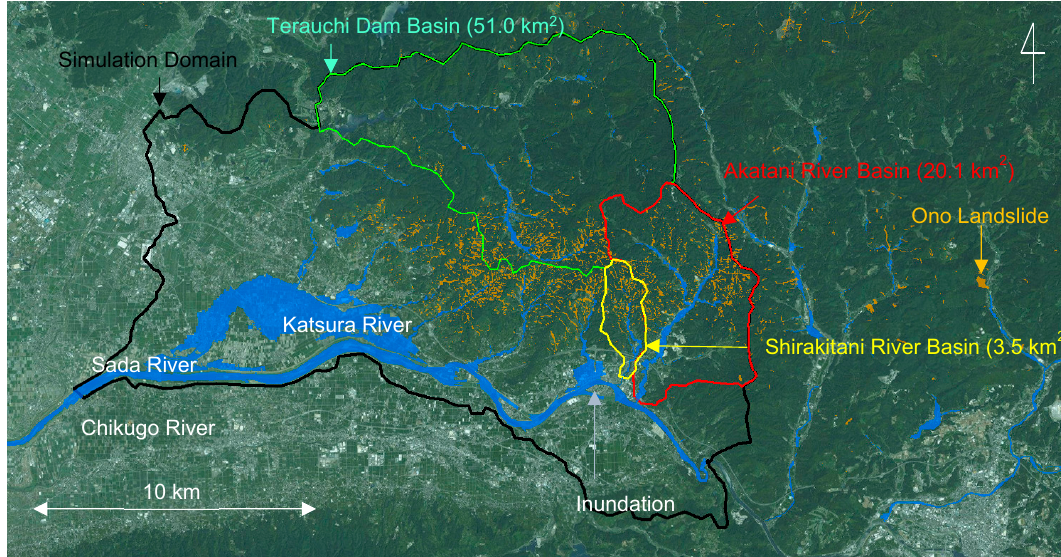
Figure 1. Disaster affected area of Northern Kyushu Island, including the Shirakitani River Basin.